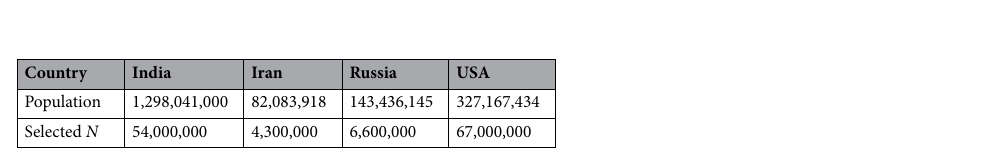
Table 2. The selected N and national